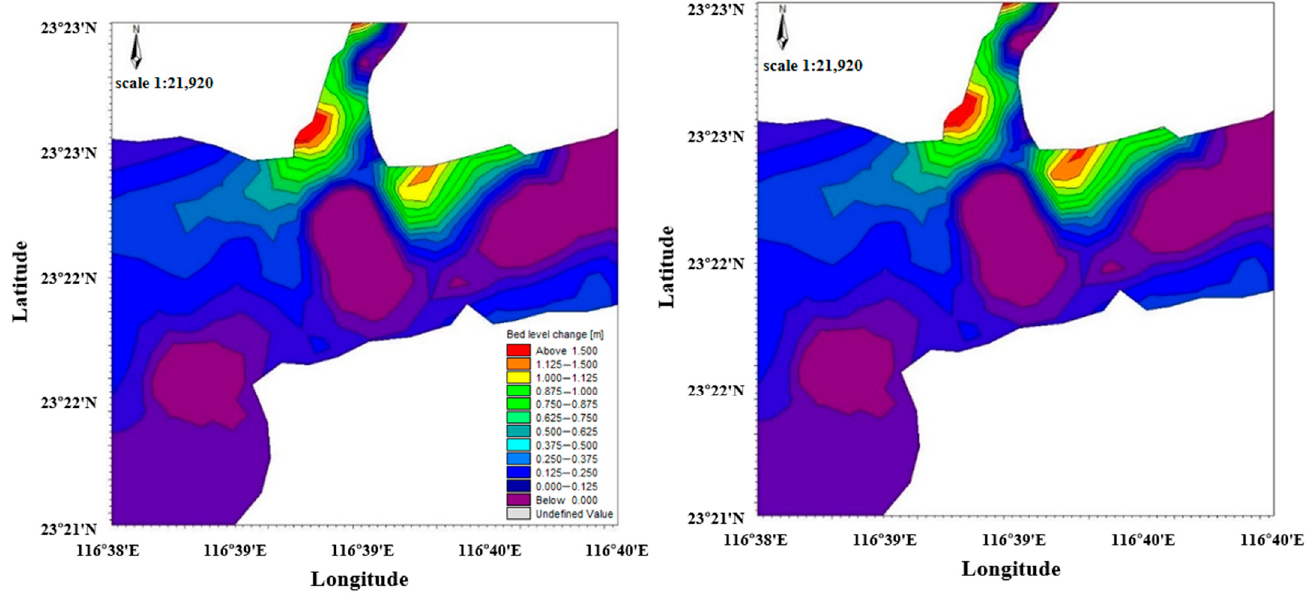
Figure 21. Sediment deposition at Meixi before and after flood discharge.